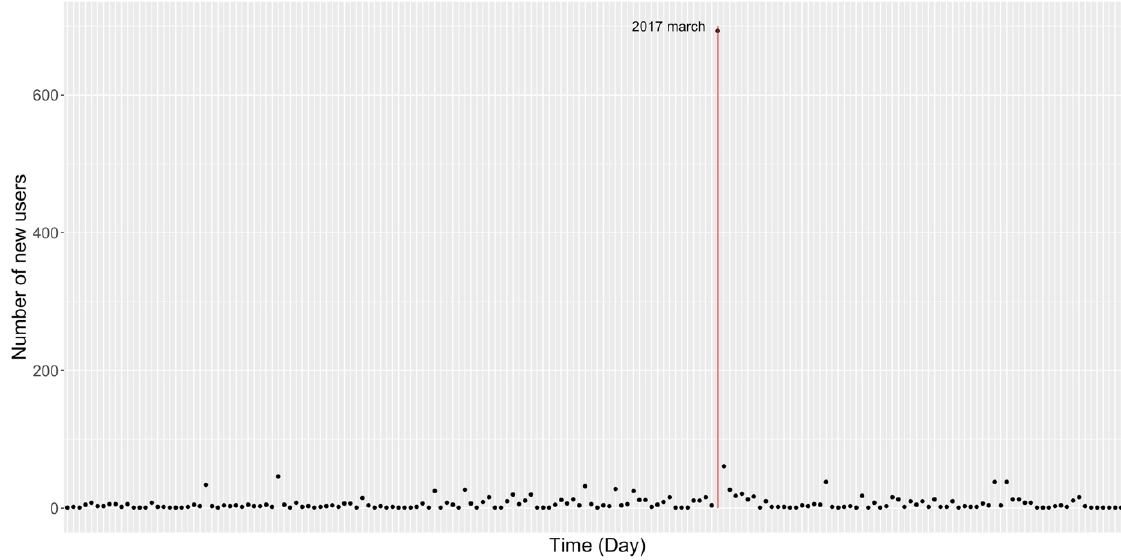
Figure 2. New users’ interaction with the TBC Facebook page in 2017.